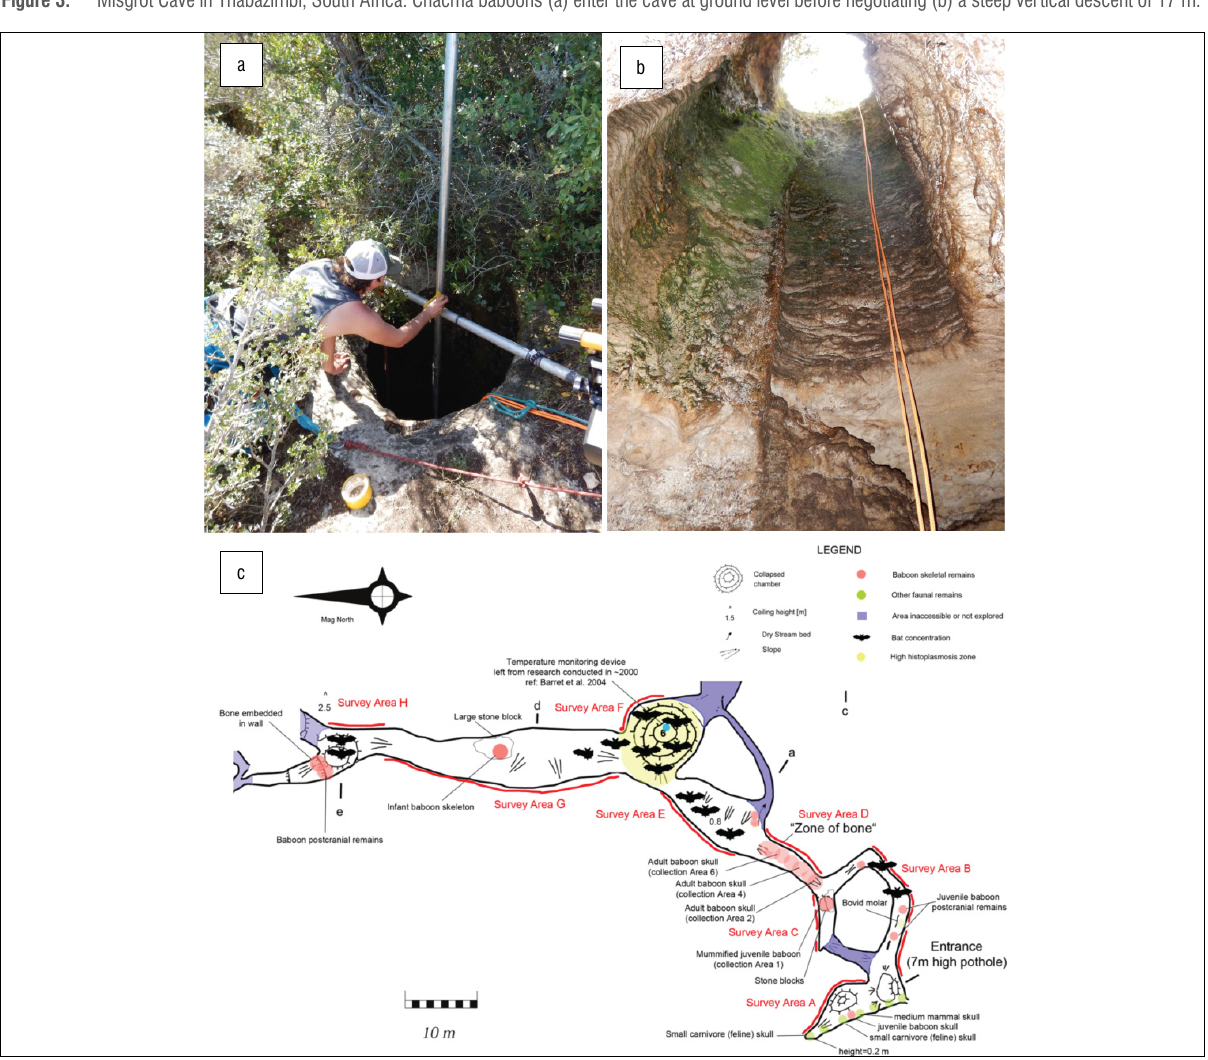
Figure 4: Dronkvlei Cave, De Hoop Nature Reserve, South Africa. Chacma baboons (a) enter the cave through a 1-m opening at ground level before negotiating (b) a vertical descent of 7 m. The preferred surface of the baboons is clearly differentiated by a dark patina. This surface area